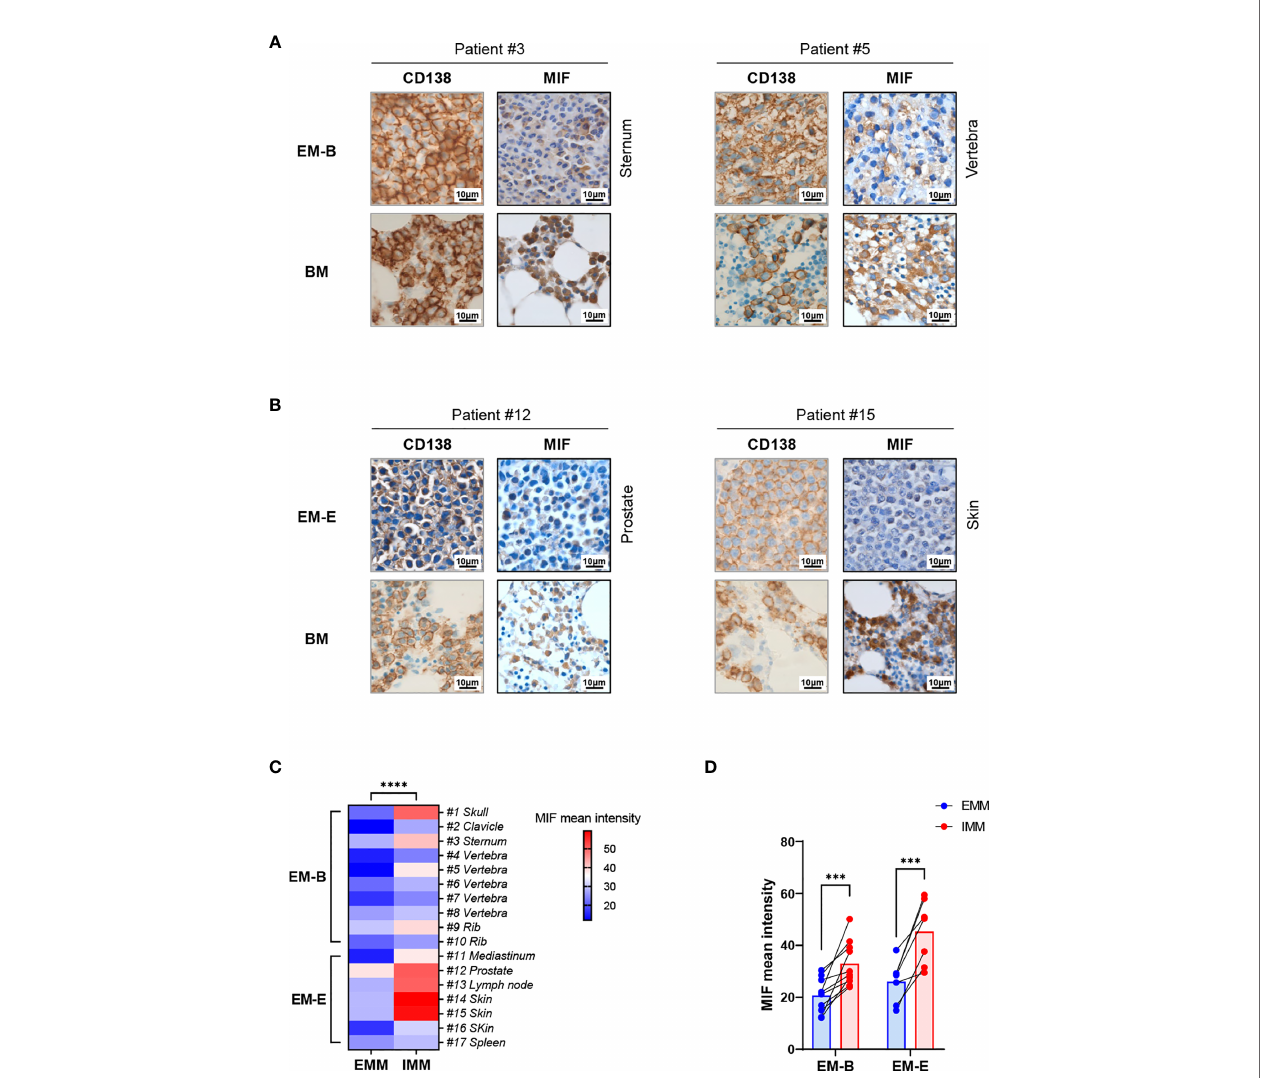
FIGURE 1 | IHC staining showing MIF expression in EMM versus corresponding IMM. (A, B) IHC staining for CD138 and MIF in the paired samples from representative cases: the plasma cells highlighted by CD138 show higher MIF expression in IMM than in paired EMM, either for EM-B (A) or for EM-E ( B ; magni fi cation 100×). (C, D) MIF intensity quanti fi cation based on wide- fi eld IHC imaging indicates its intratumor heterogeneity; all EMM samples (n = 17) display downregulated MIF expression compared to the IMM counterparts. **** p < 0.0001, *** p < 0.001 (two-way